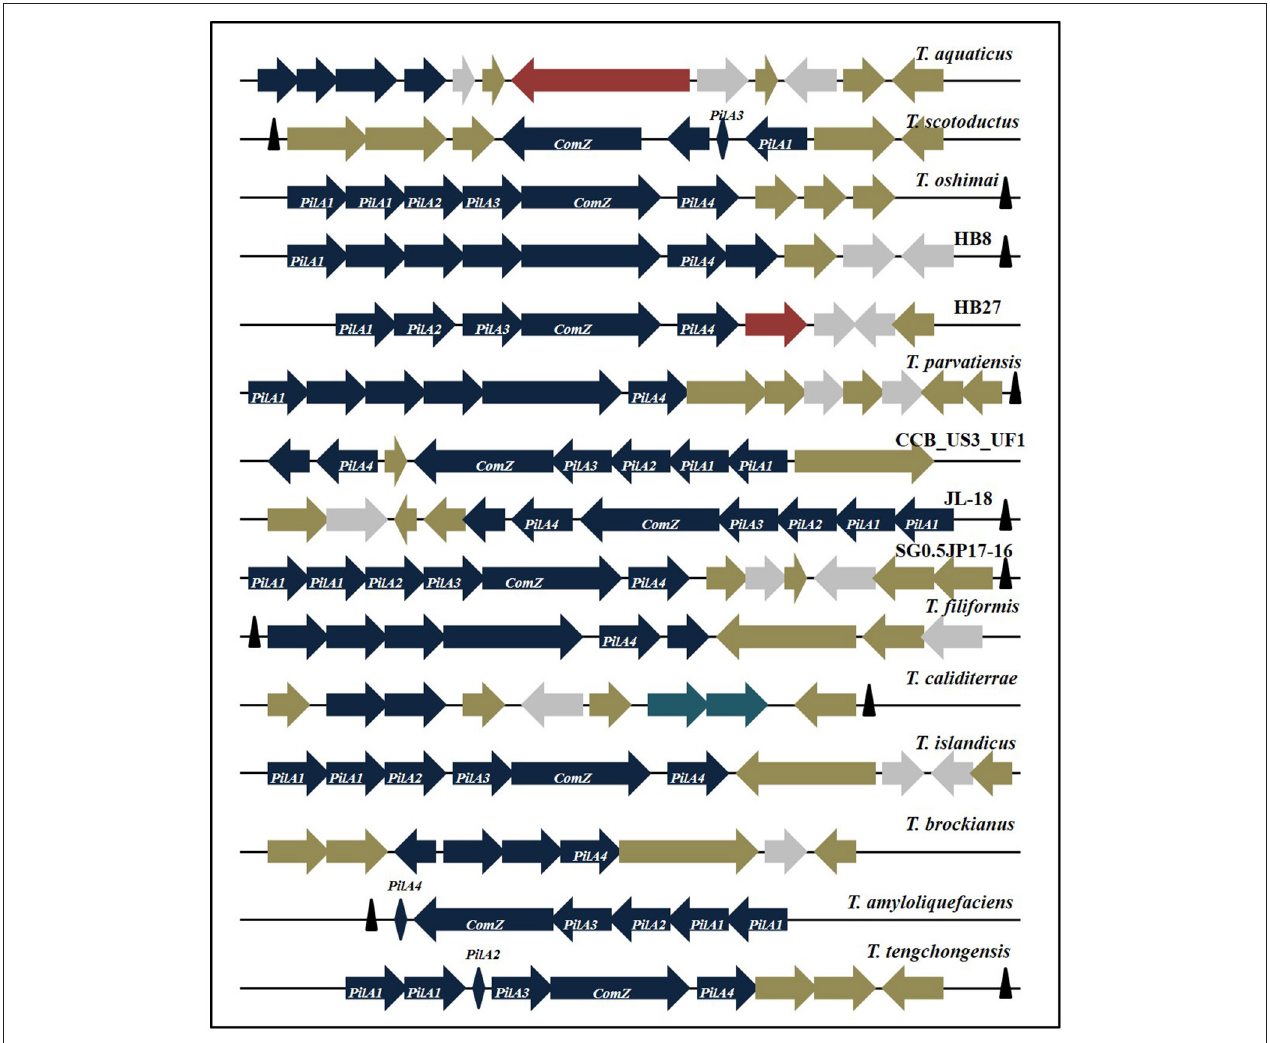
FIGURE 8 | Organization of putatively horizontally transferred PilA-ComZ locus genes from all Thermus genomes in this study. Blue, Pilus family proteins; Gray, Nucleases; Tan, Hypothetical/Conserved proteins; Maroon, Transposase/Conjugative element; Rhomboid, unformed CDS; Navy blue, Toxin-antitoxin elements; Black triangles,